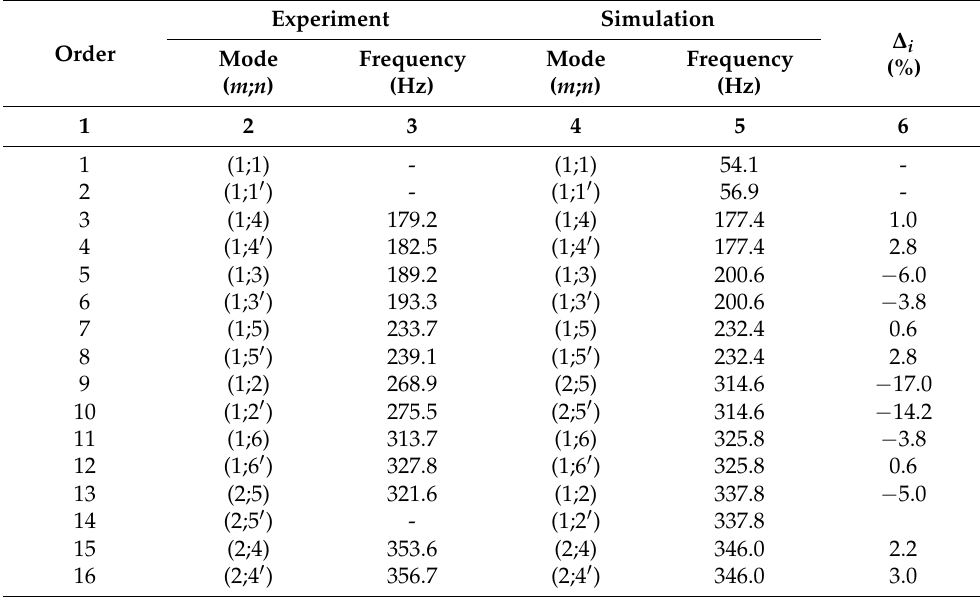
Table 4. The first numerical modes against the axial static load levels for Specimen